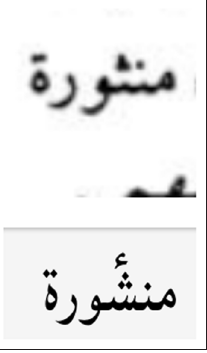
Figure 20: Inserted extra